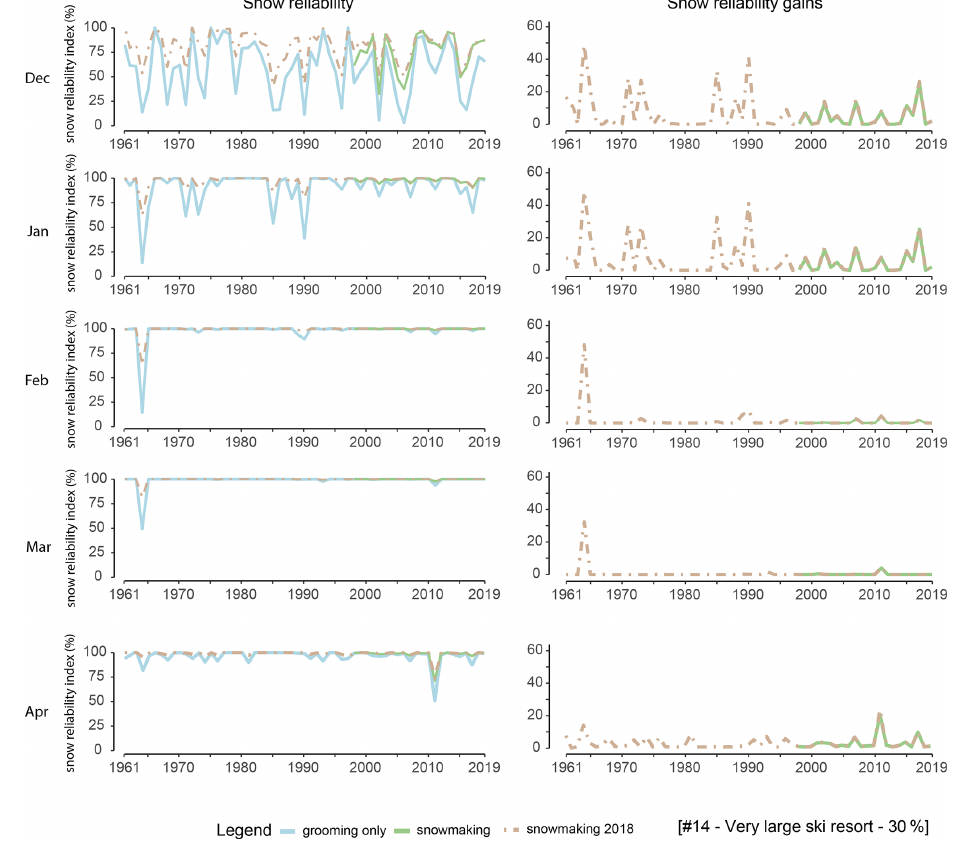
Figure 6. Similar to Fig. 5 but for ski resort no. 14 (very large ski resort, 30% of the surface area below 2000m